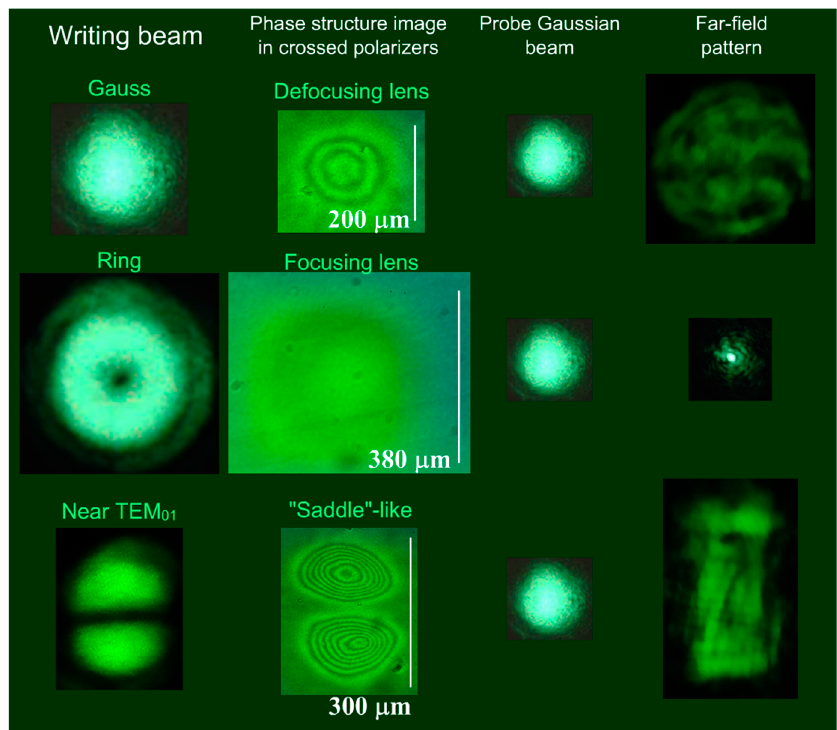
Figure 9. Demonstration of the possibilities of optical recording with di ff erent shapes of the light beam ( δ = 4.3). First row: Gaussian beam (2 w = 200 µ m) induces a nonlinear phase structure, which acts as a defocusing lens; the divergence of the probe Gaussian beam, passing through the central part of the structure, increases. Second row: ring-shaped beam (beam size ≈ 350 µ m) induces a ring-shaped phase structure, which acts as a focusing lens for the probe beam, passing through the central part of the structure. Third row: a TEM 01 -like beam (vertical beam size ≈ 300 µ m) induces a phase structure with a saddle-like profile in its central part; probe beam, passing through this region undergo a complex deformation, acquiring a rectangular form. The probe beam and aberration patterns are given on